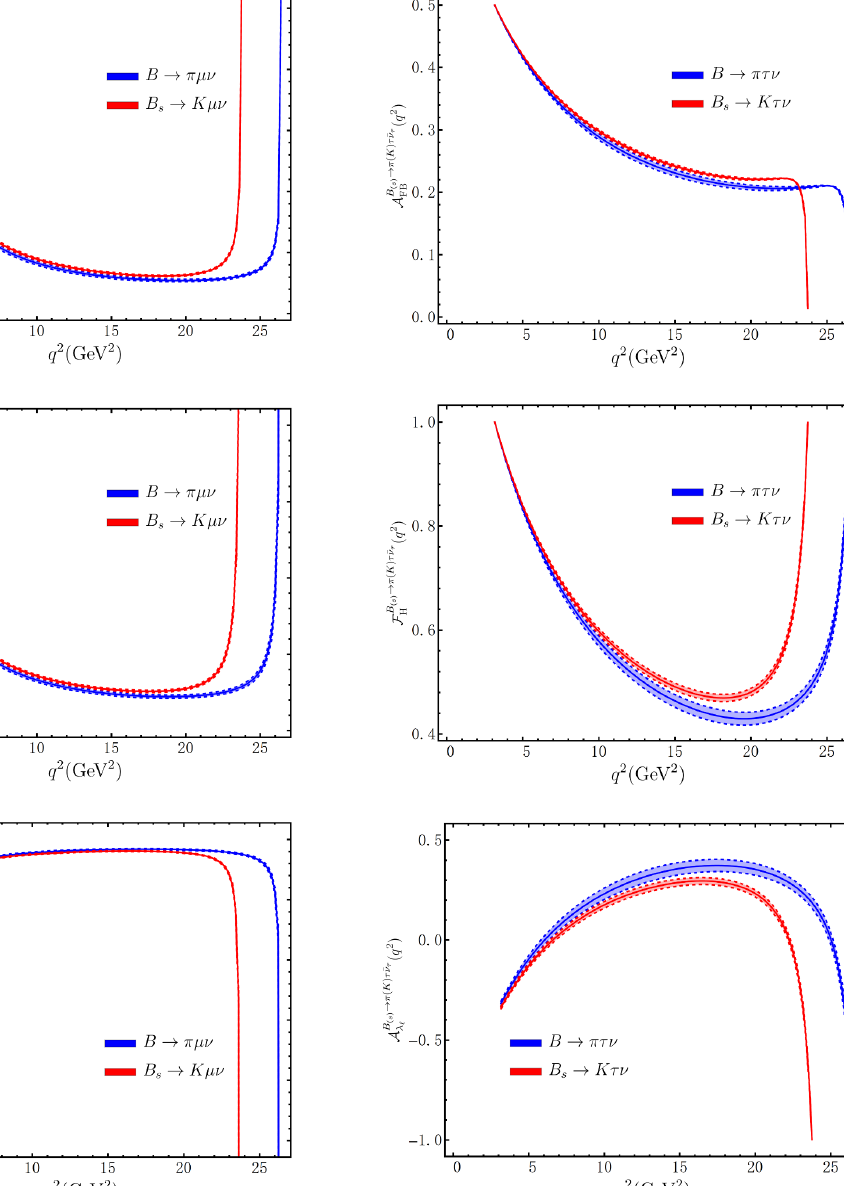
Figure 14 . Theory predictions for the three distinct classes of the angular observables ( q 2 ) , F B ( s ) → π ( K ) ‘ ¯ ν ‘ A B ( s ) → π ( K ) ‘ ¯ ν ‘ FB H expansion fitting against the synthetic lattice data points and the newly obtained bottom-meson LCSR